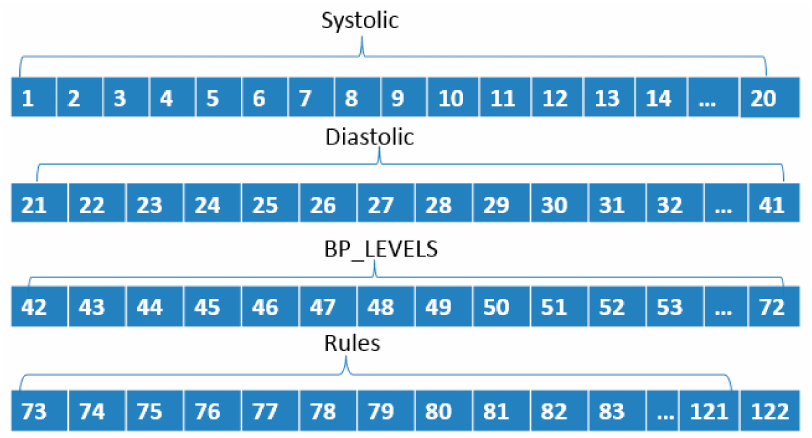
Figure 15. Structure of the chromosome.